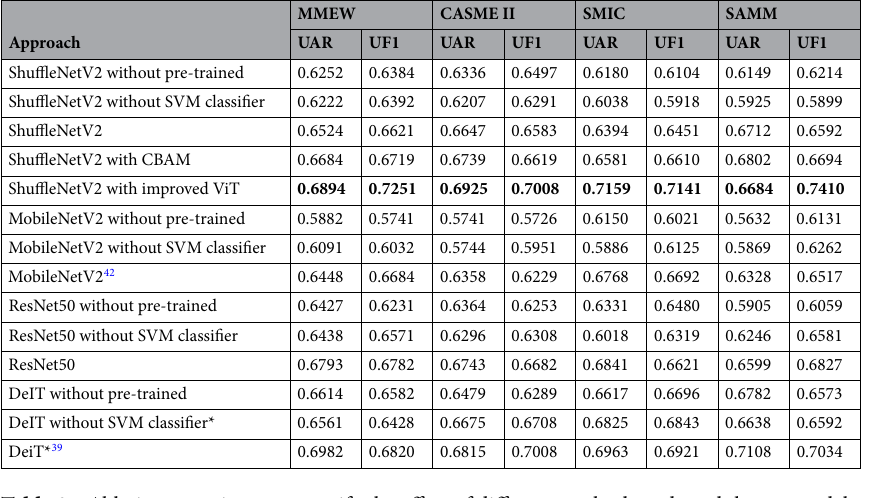
Table 2. Ablation experiments to verify the effect of different methods and modules on model recognition accuracy. The test results of our proposed method are shown in